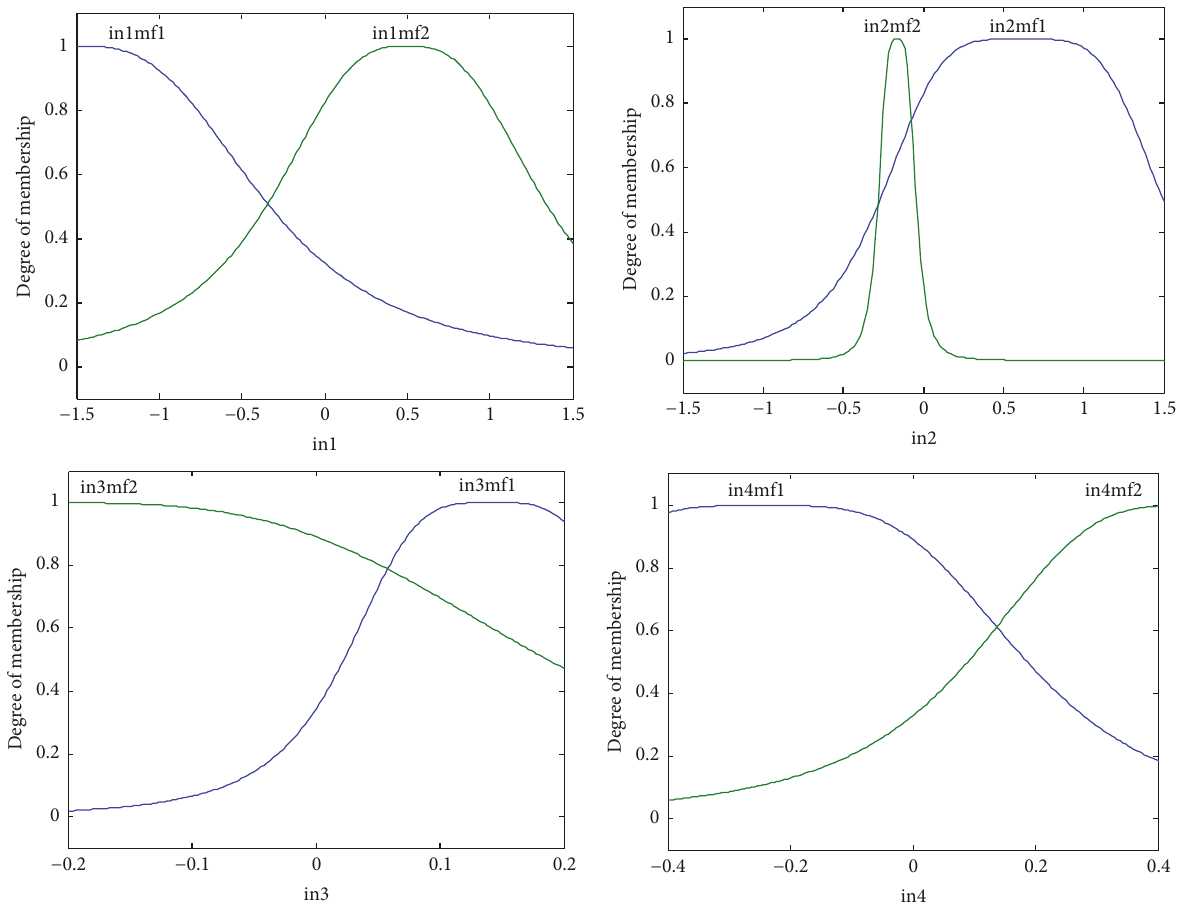
Figure 15: Best Distribution membership function found by